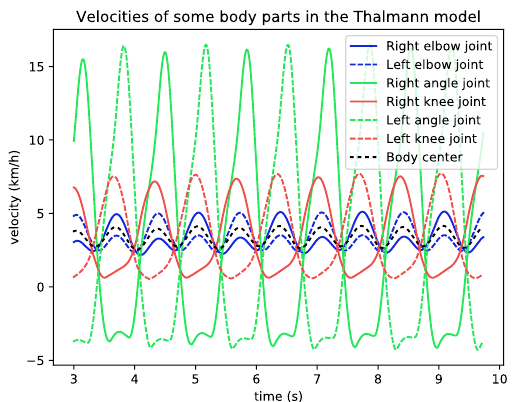
Figure 3. The velocities of some (not all) body parts can be seen here. The mean velocity is about 4 km/h and that the ankles reach the largest